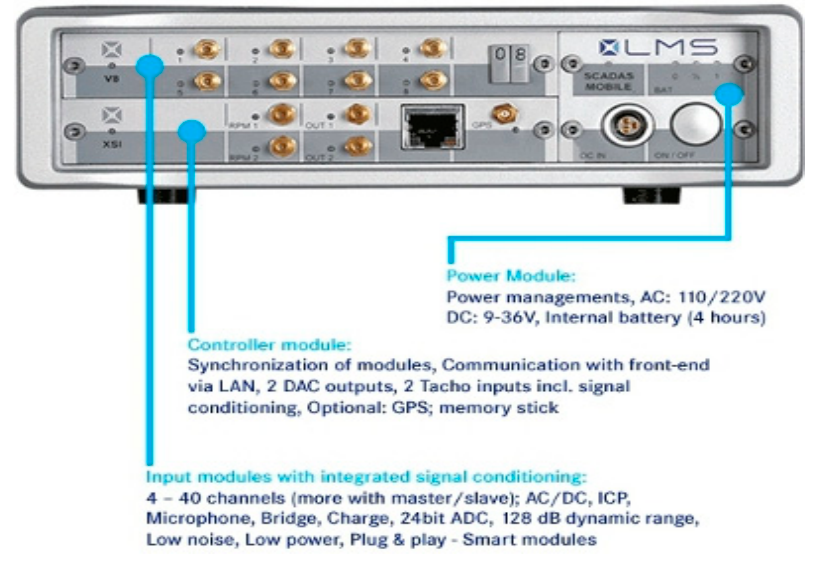
Figure 8. SIEMENS LMS SCADAS